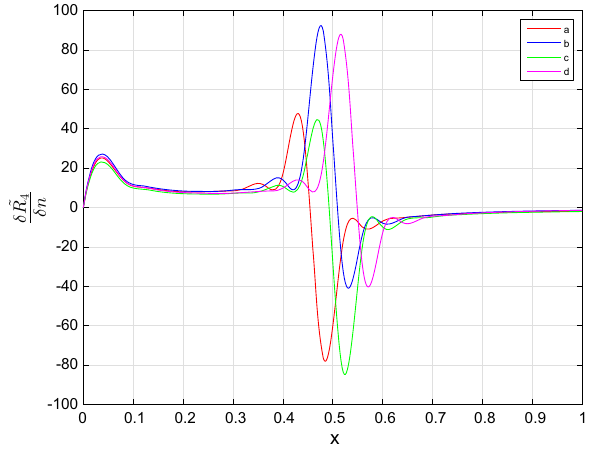
as a function of x for n